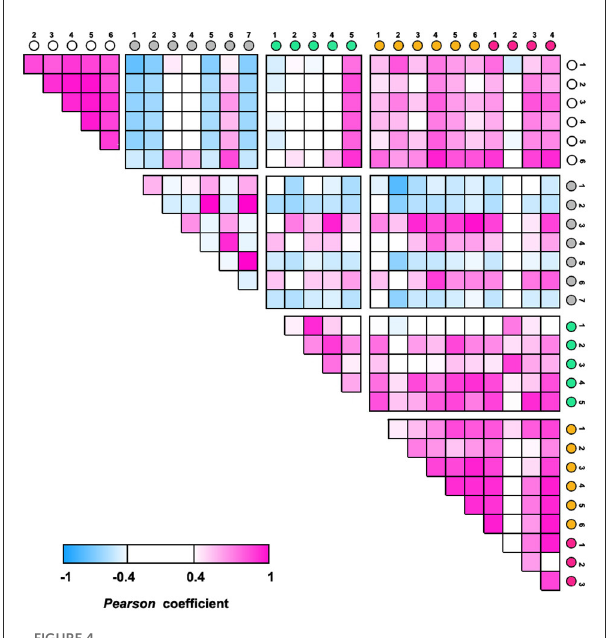
FIGURE4 Pearson coefficient analysis among groups using the relative abundances of the top 10 significant